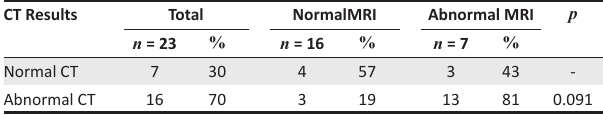
TABLE 3: Magnetic resonance imaging results in relation to computerised tomography